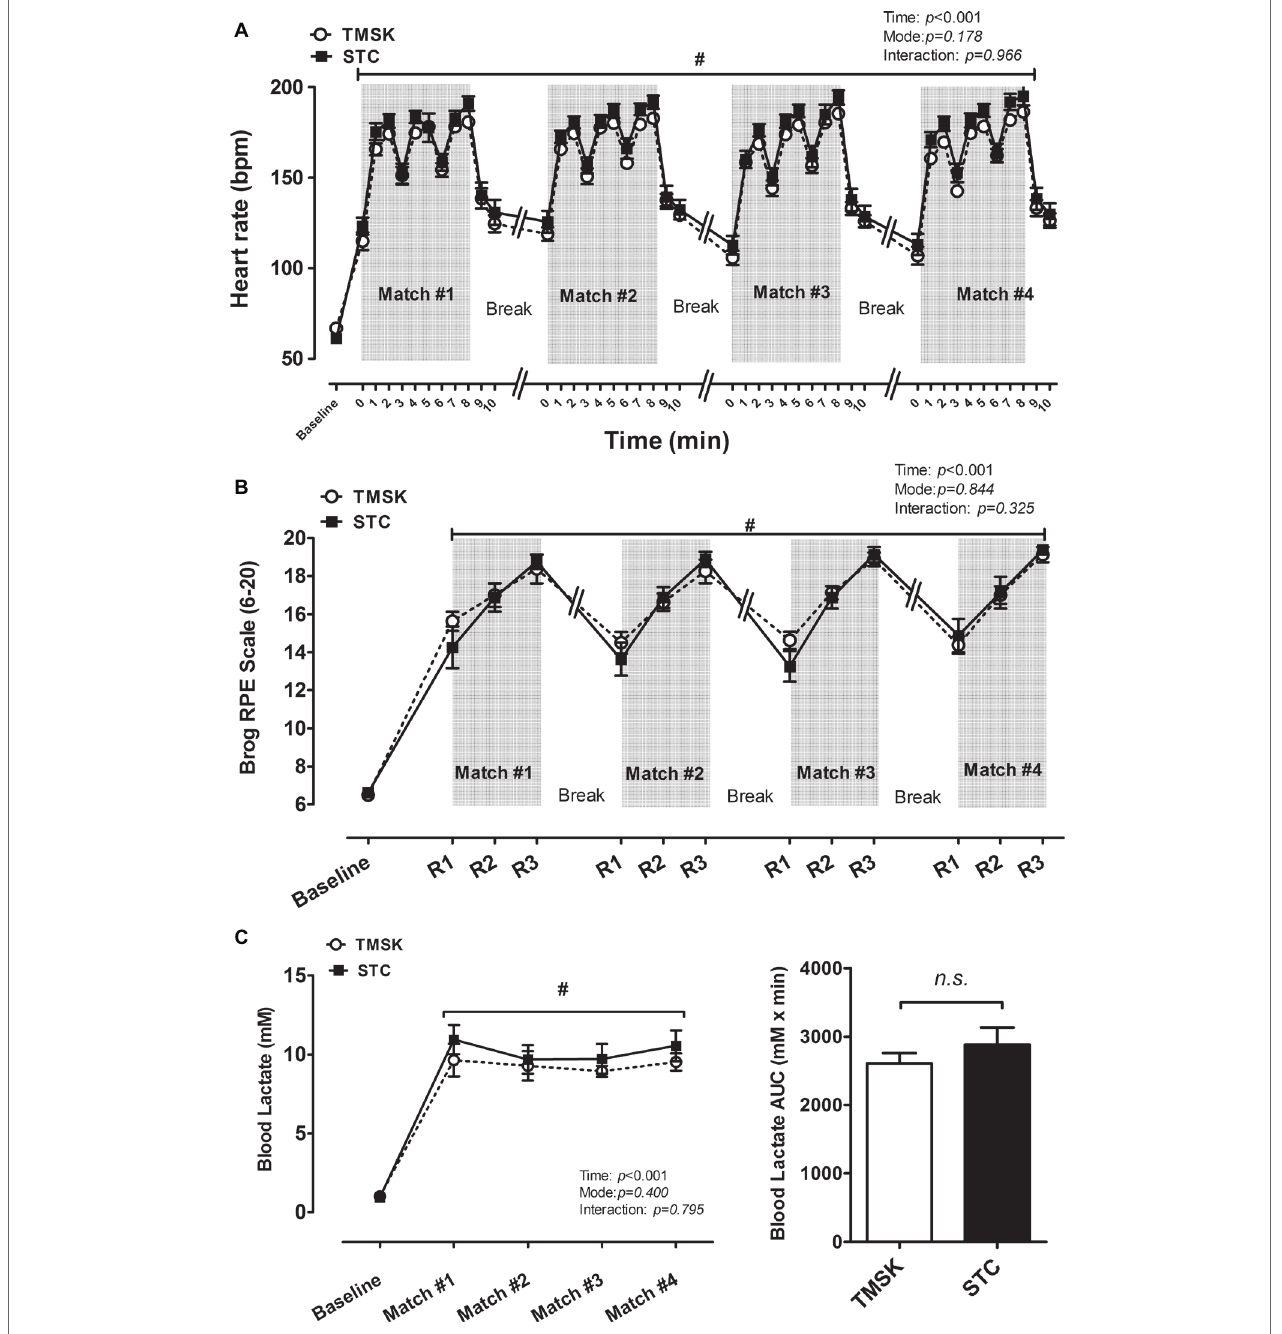
FIGURE 2 | The physiological responses during real combat match and simulation kicking exercise. (A) heart rate, (B) blood lactate, and (C) subjective Borg RPE. # denotes significant difference compared to baseline values ( p < 0.05). TMSK: TKD-match simulated kicks; STC: simulated TKD